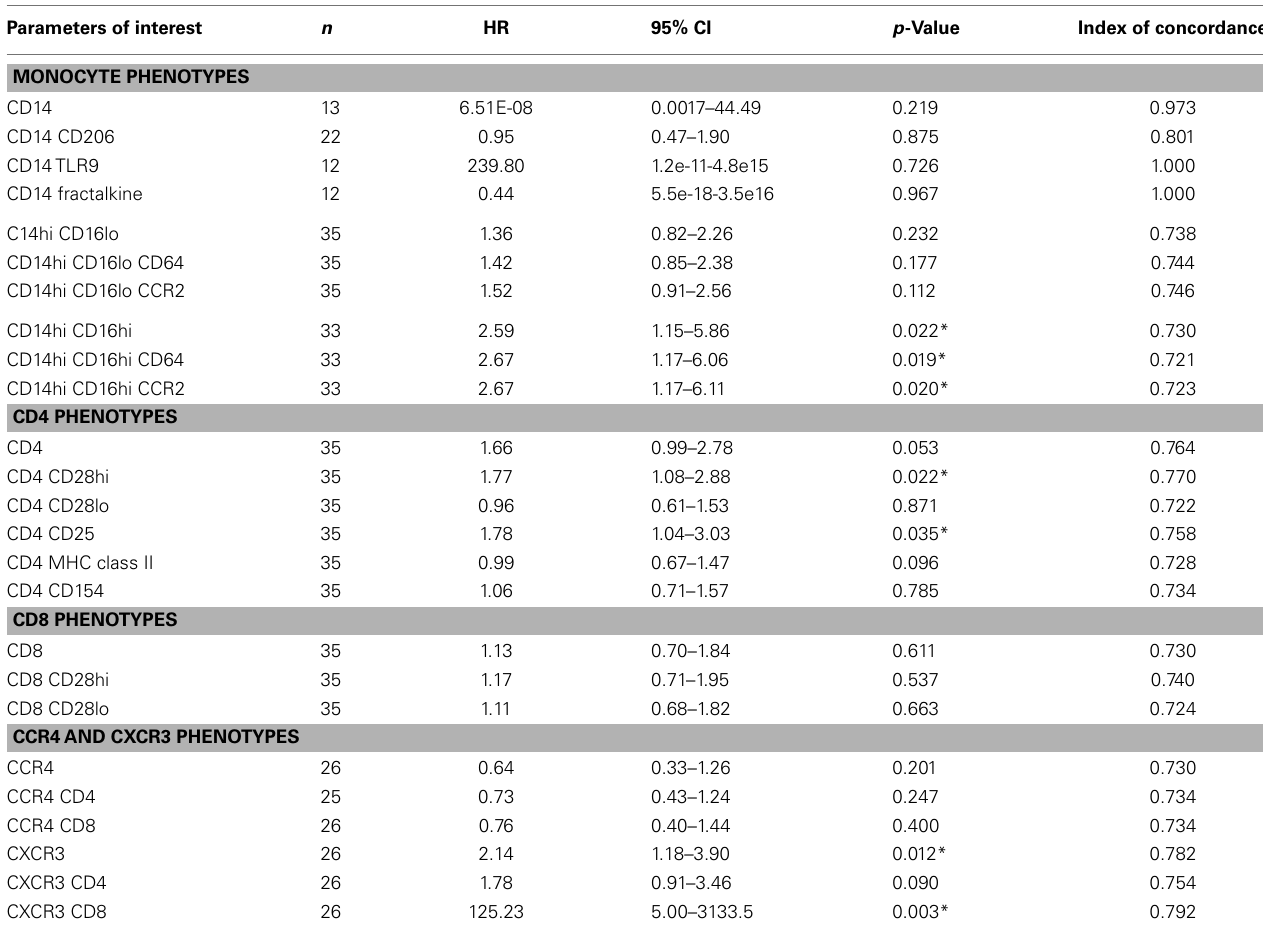
Table 4 | Cox model results based on standardized biomarker level values adjusted for age, gender, dlco10%, fvc10%, desaturation, gastroesophageal reflux disease and smoke status